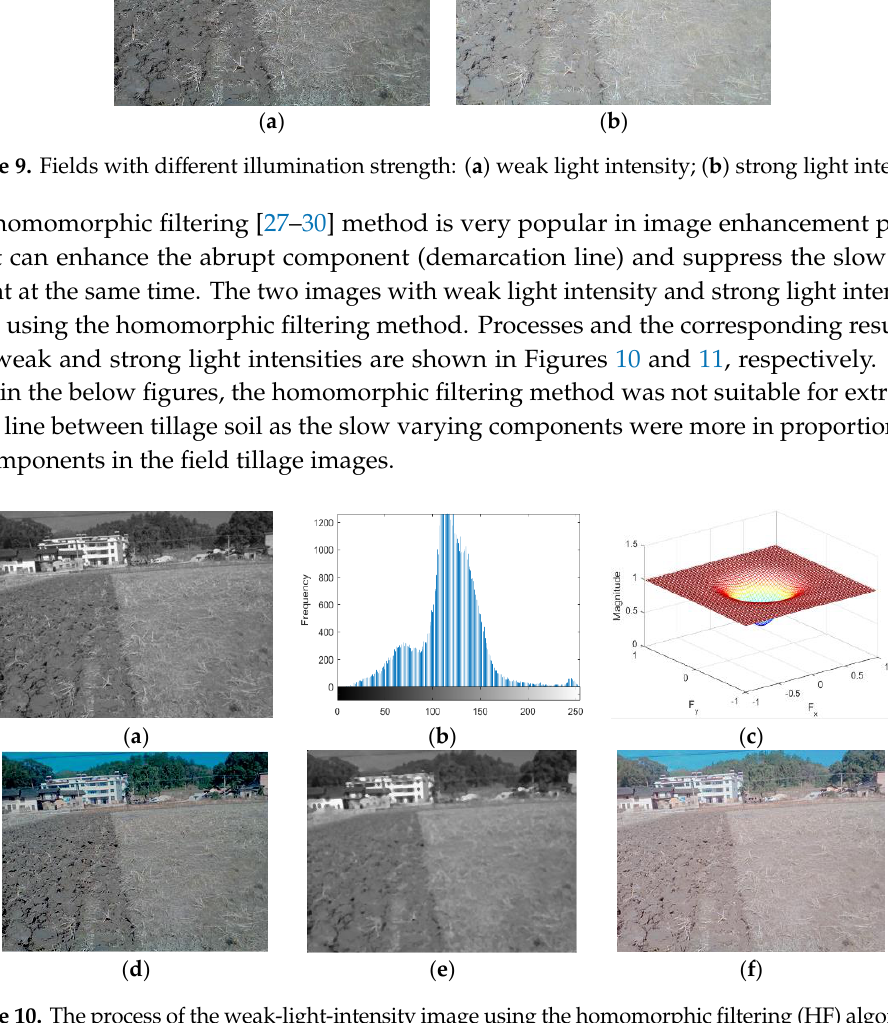
Figure 10. The process of the weak-light-intensity image using the homomorphic filtering (HF) algorithm: ( a ) grayscale; ( b ) grayscale histogram; ( c ) frequency response of the high-pass filter; ( d ) Butterworth high-pass filtering; ( e ) median filtering; ( f ) homomorphic filtering.